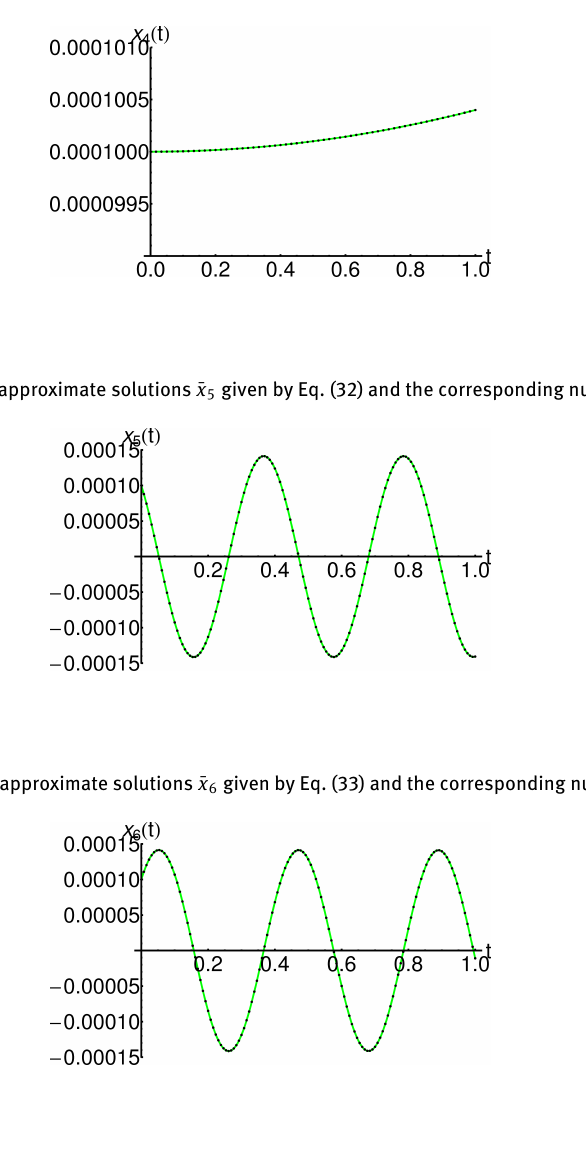
Fig. 4. Comparison between the approximate solutions ¯ x 4 given by Eq. (31) and the corresponding numerical solutions